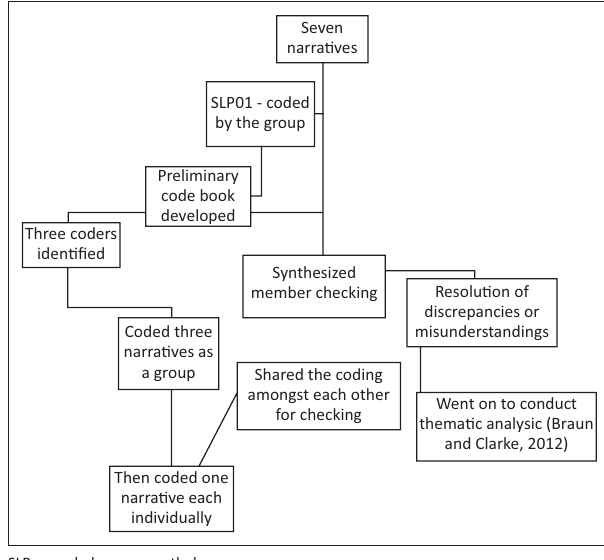
FIGURE 1: Process followed in coding the